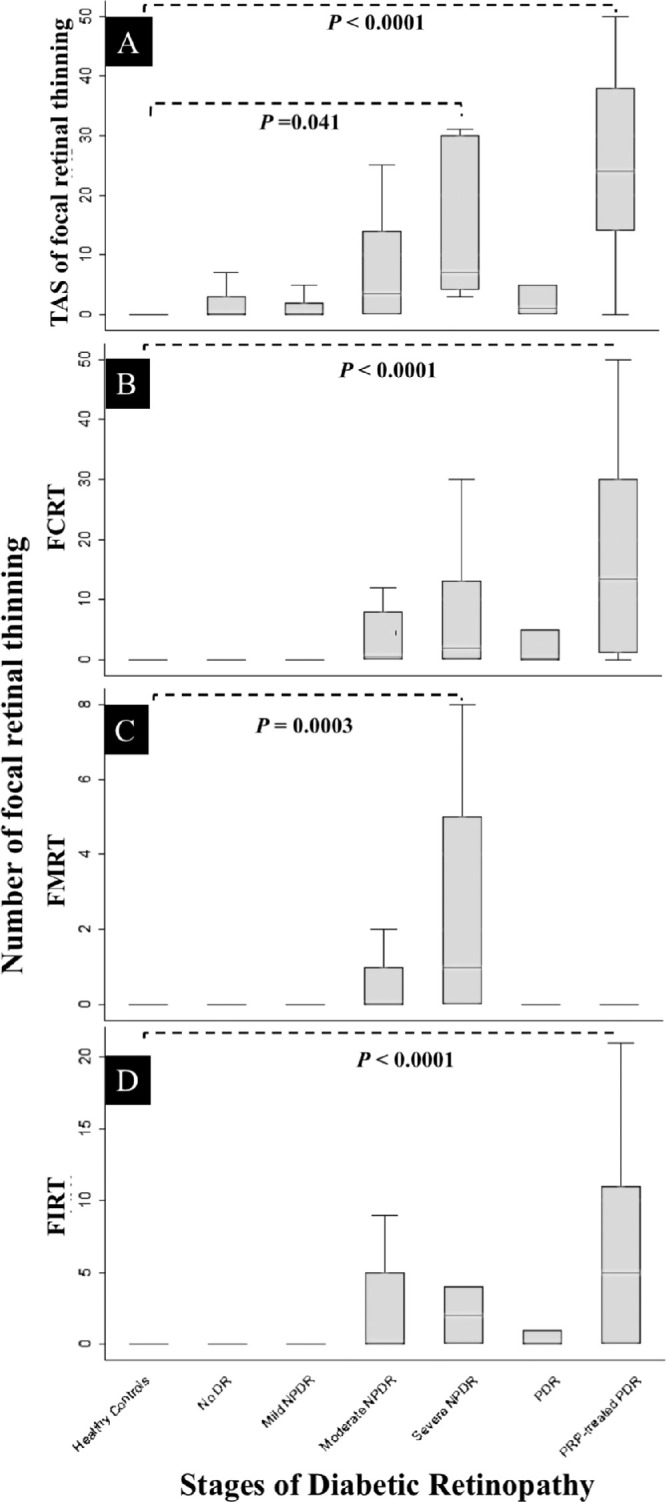
Boxplot of mean values for TAS of focal retinal thinning, FCRT, FMRT, and FIRT (A, B, C, and D, respectively) plotted against healthy controls and grade of DR.